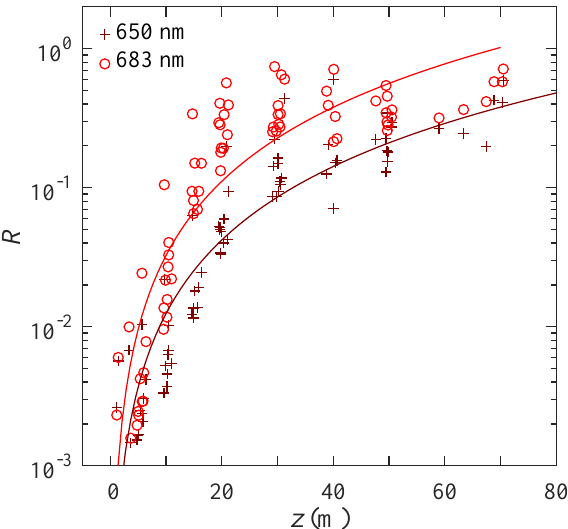
Figure 11. Irradiance reflectance R in the red spectral bands (650 and 683 nm as indicated) plotted as a function of depth z using data from all stations and depths. Solid lines represent the best-fit regression